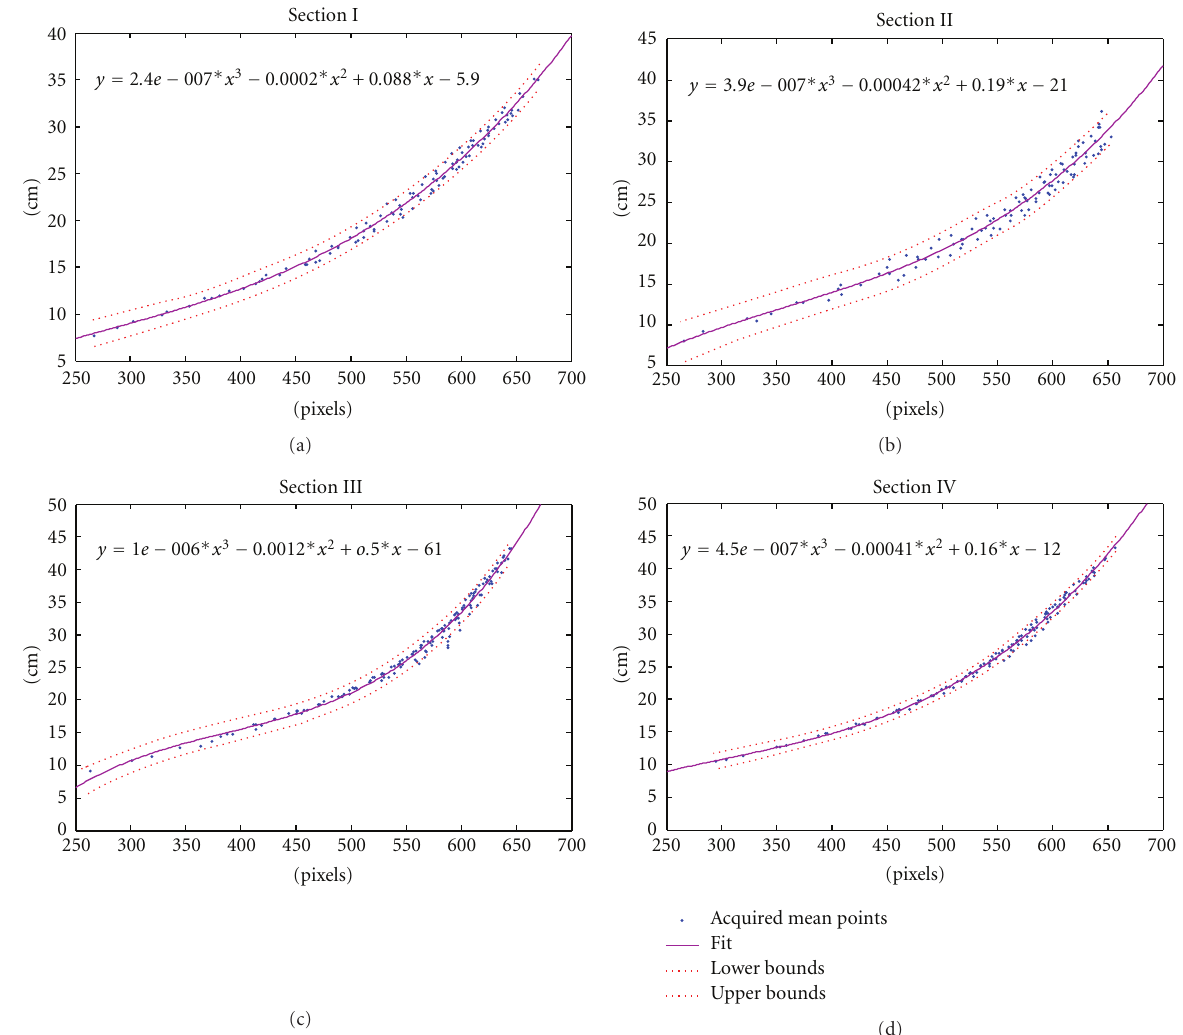
Figure 7: Polynomial fitting for distance estimation for sections I, II, III and